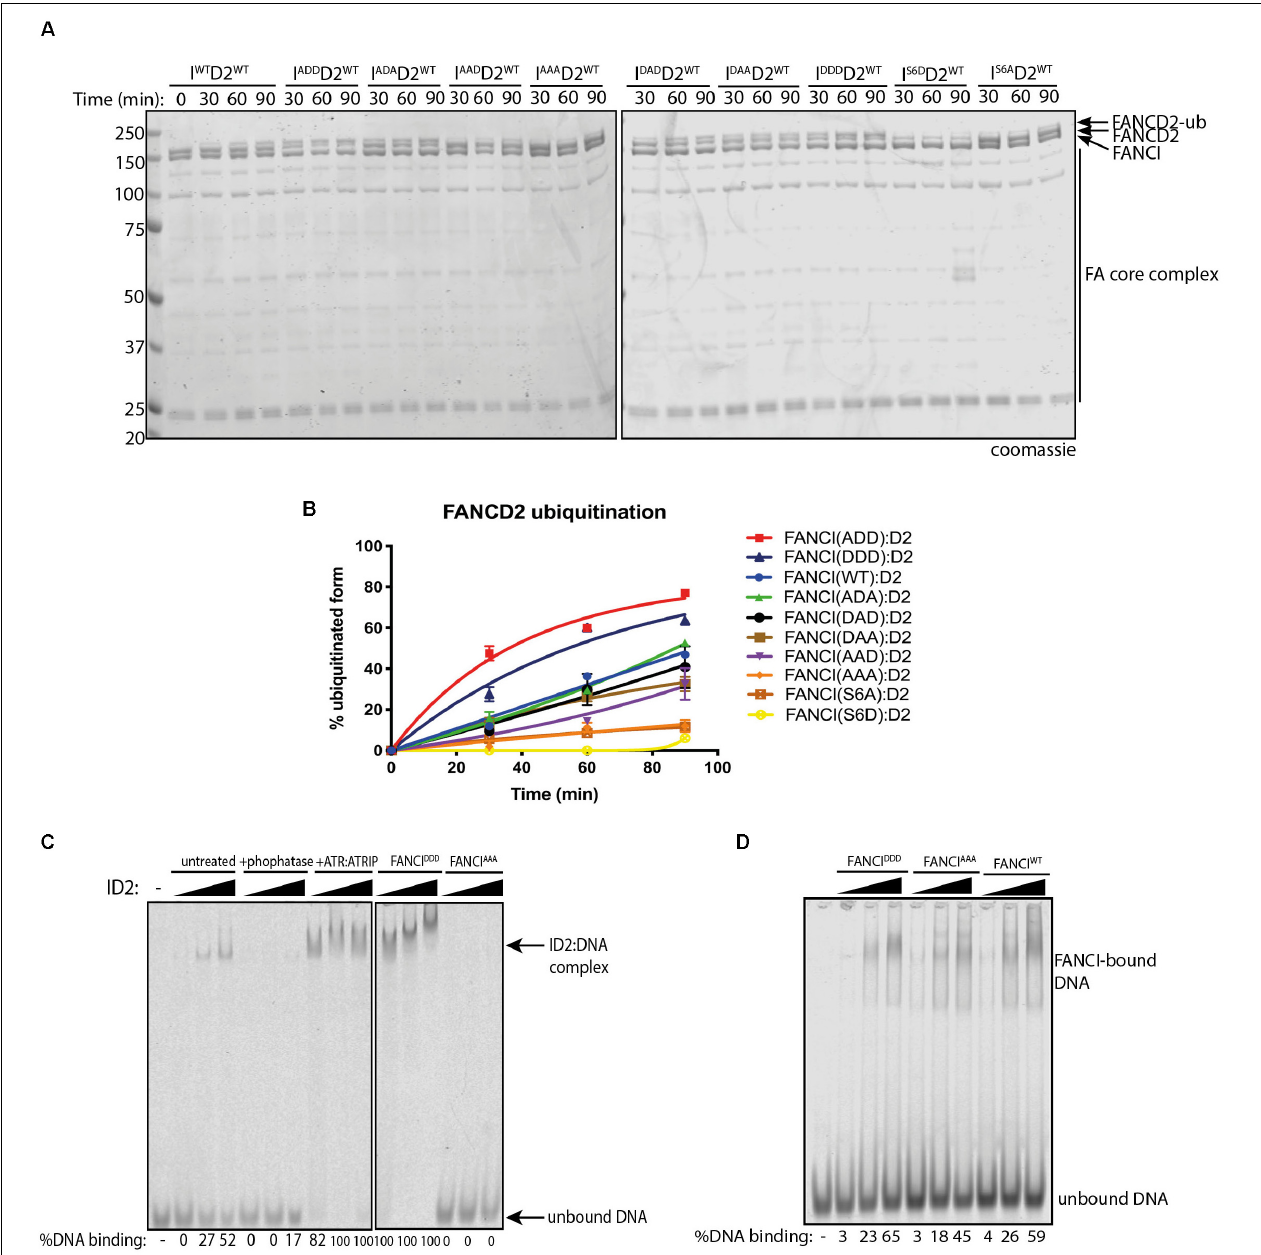
FIGURE 3 | FANCI phosphorylation in the S3Q cluster regulates FANCD2 ubiquitination by increasing its retention on DNA. (A) In vitro ubiquitination assays of various FANCI-phosphomutant:FANCD2 complexes showing that phosphomimic mutants present higher ubiquitination rate than phosphodead mutant. (B) Quantification showing the percentage of FANCD2 monoubiquitination using various FANCI phosphomutants. Data are representative of three experiments. (C) Electro mobility shift assay (EMSA) gels showing 100. 200 and 400 nM of untreated, phosphatase or ATR: ATRIP treated ID2 (WT. DDD or AAA) complexes and (D) isolated FANCI (WT. DDD or AAA) proteins in the presence of 25 nM IRDye-700 dsDNA. The percentage of protein binding to DNA was calculated and shown under native PAGE gels. Data are representative of three experiments.